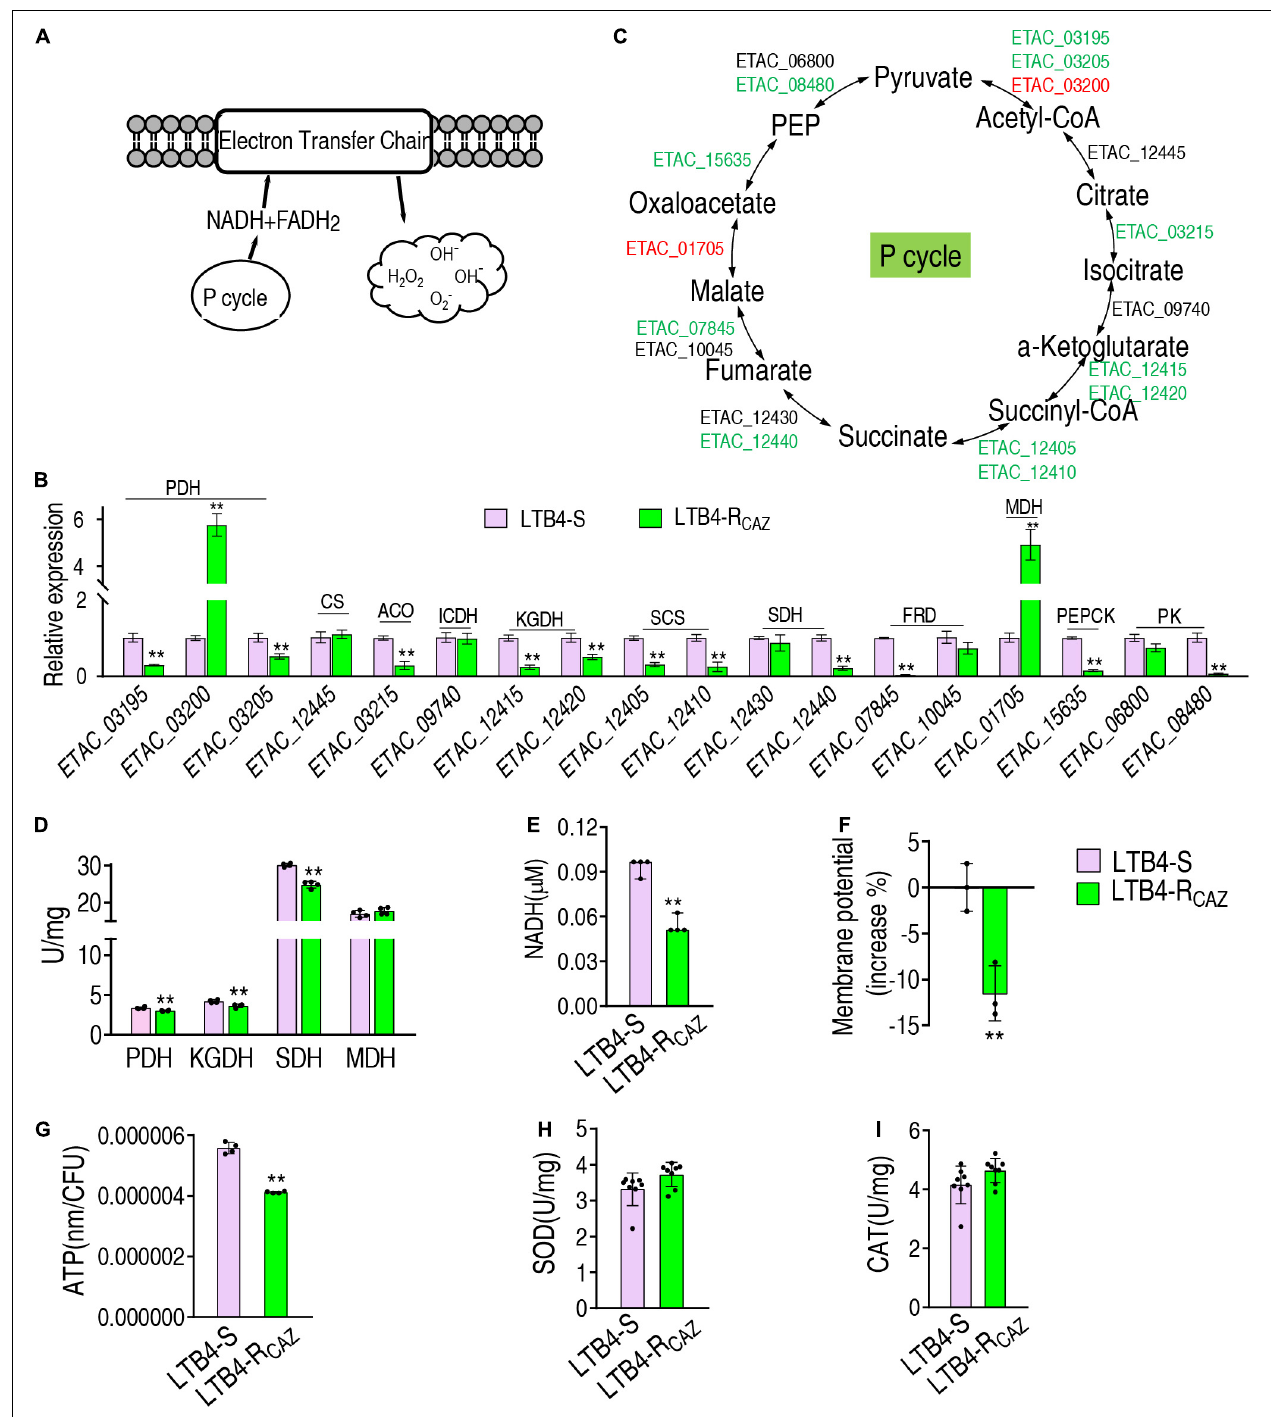
FIGURE 3 | The P cycle, NADH, and ATP in LTB4-S and LTB4-R CAZ . (A) Sketch diagram describing the effect of the P cycle on ROS. (B) Real-time quantitative PCR (qRT-PCR) for the expression of the P cycle-related genes in LTB4-R CAZ compared to LTB4-S. (C) A global view for transcription level of the P cycle genes. Red and blue indicate upregulated and downregulated expression, respectively. (D) The activity of PDH, KGDH, SDH, and MDH in the P cycle. NADH (E) , membrane potential (F) , and ATP (G) concentrations in LTB4-S and LTB4-R CAZ . The activity of superoxide dismutase (SOD) (H) and catalase (CAT) (I) in LTB4-S and LTB4-R CAZ . Results (B,D–I) are displayed as mean ± SEM, as determined by two-tailed Student’s t -test. Four biological repeats are carried out. ** P <